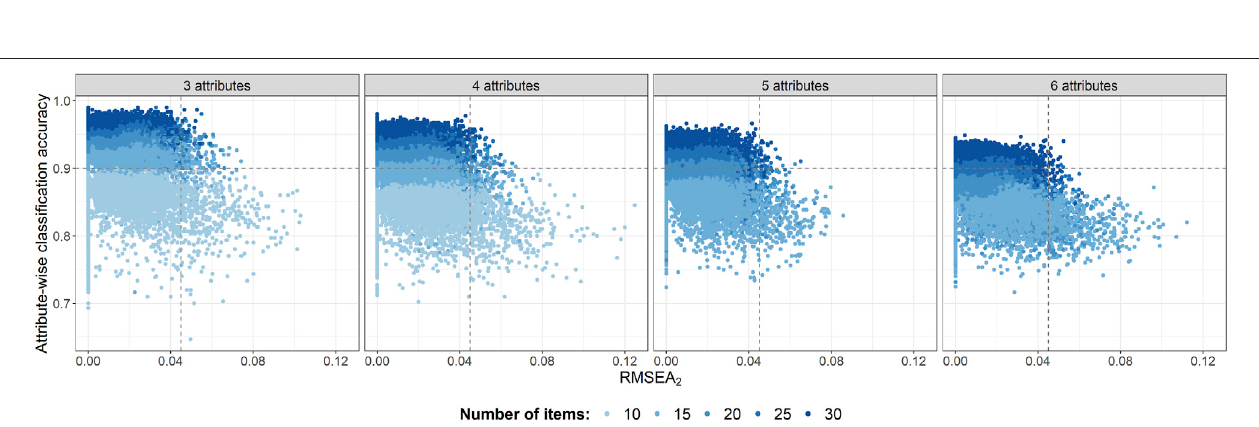
FIGURE 2 | Average RMSEA 2 (with 90% error bars) in the conditions resulting from crossing the number of attributes A , items I , and respondents R for which the generating model was consistent with the estimated model. Horizontal dashed lines indicate RMSEA 2 of